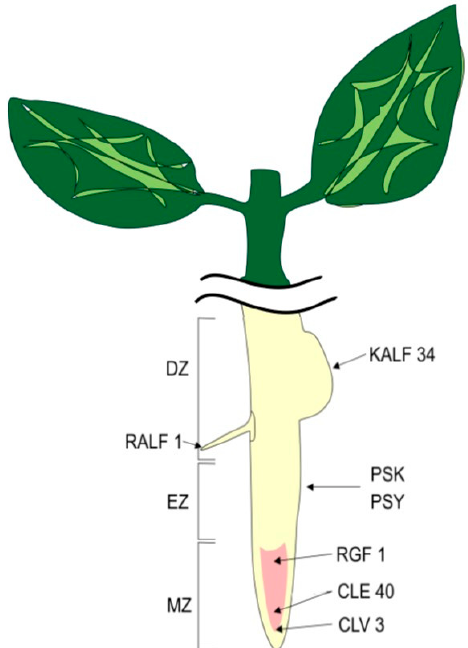
Figure 2. Localization of peptides in root zones. MZ—meristematic zone, EZ—elongation zone, DZ—differential